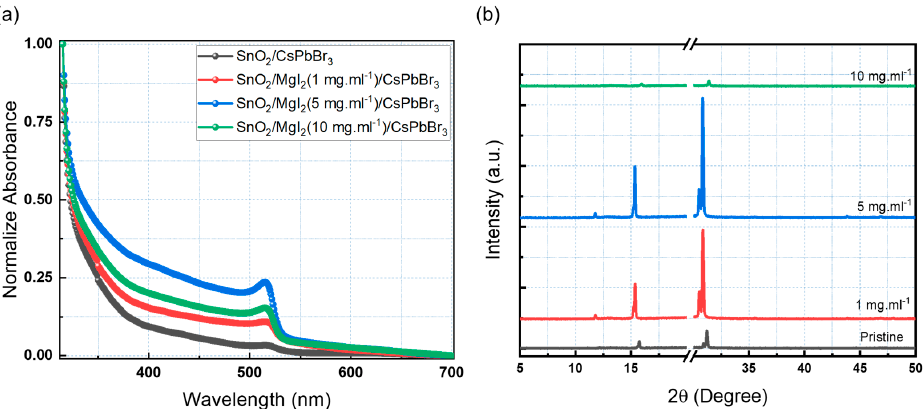
Figure 3. ( a ) Absorption spectra and ( b ) XRD spectra of the perovskite with different concentrations of MgI 2 .